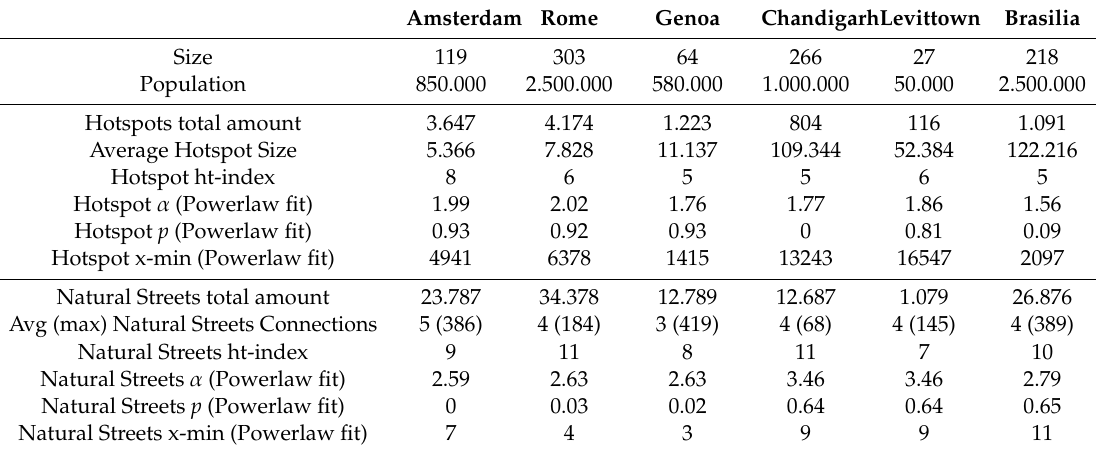
Table 2. Comparison of statistics between the six analyzed